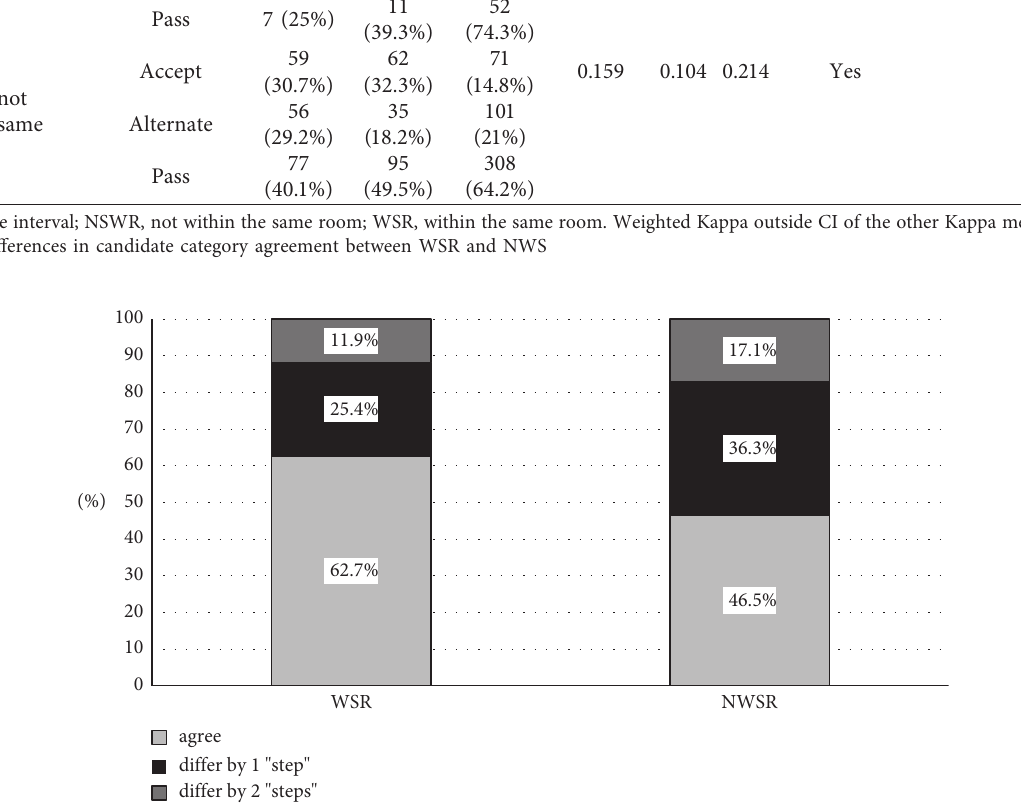
Figure 1: Candidate category (“accept,” “alternate,” and “pass”) agreements between pairs of interviewers who were within the same virtual interview room (WSR) and not within the same virtual interview room (NWSR); “differ by 1 step” denotes a difference between “accept” and “alternate” or “alternate” and “pass,” whereas “differ by 2 steps” denotes a difference between “accept” and “pass.”